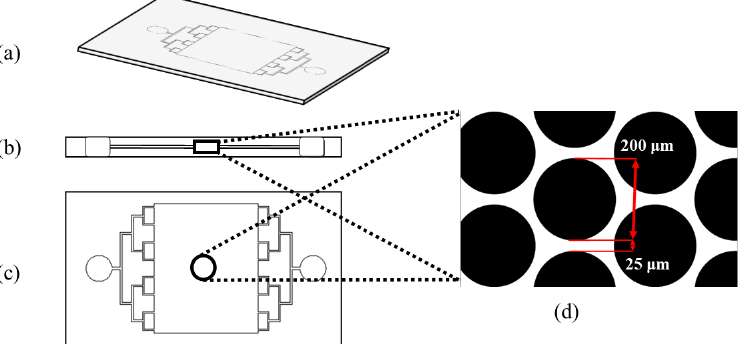
Figure 1. Illustration of the ( a ) microfluidic device used in this work, with its ( b ) length-wise cross sectional view, ( c ) top-down view, and the ( d ) artificial geometry with 200µm circular grain size and 25µm